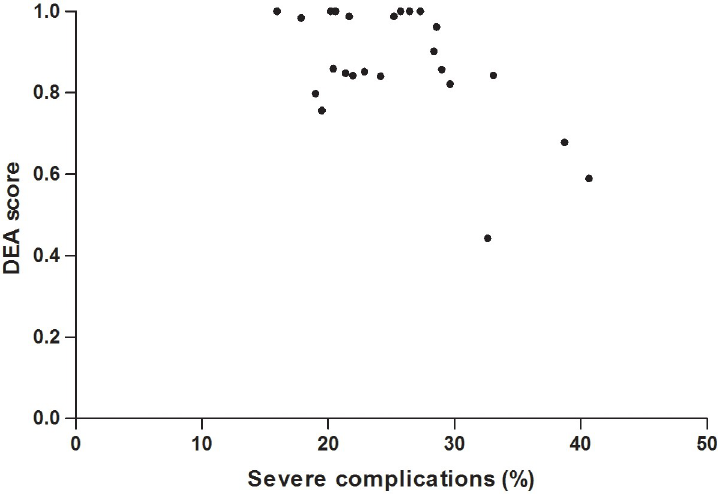
Fig 1. Distribution of hospital uncorrected (non-parametric) DEA scores in proportion to the percentage of severe complications (output).